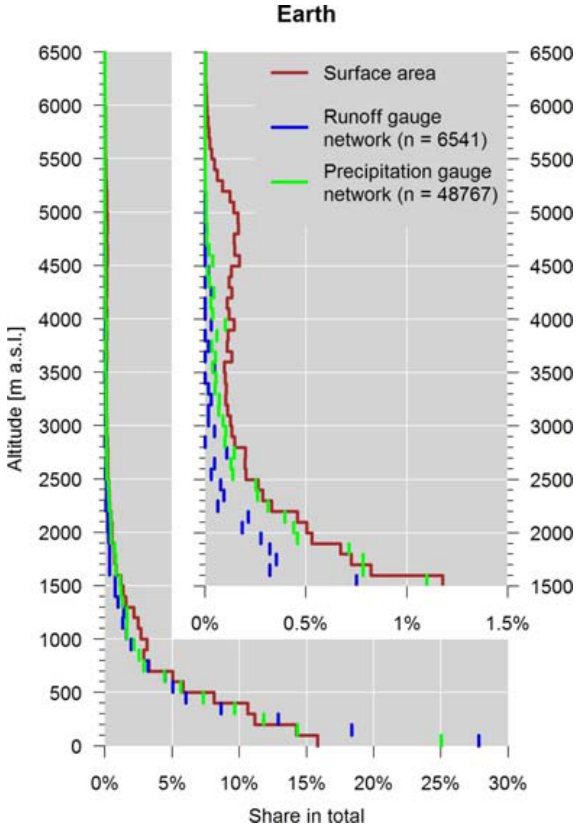
Fig. 3. Altitudinal distribution of global runoff stations represented in the GRDC archive and global precipitation station network rep- resented in the GPCC archive compared to global hypsography of the land surface area (without Greenland and Antarctica). The inset shows a magnification for altitudes above 1500ma.s.l. Figure 3 characterises the global runoff and